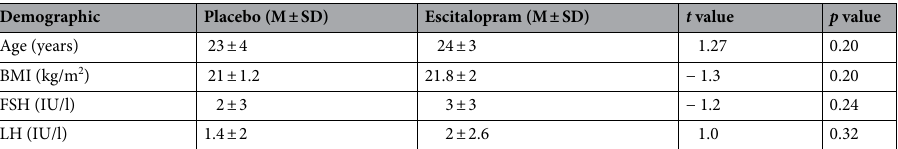
Table 1. Results from independent sample t -tests assessing potential group differences for participant age, body mass index (BMI), Follicle stimulating hormone (FSH) levels, Luteinizing hormone (LH) levels. Mean ± Standard Deviation (M ±